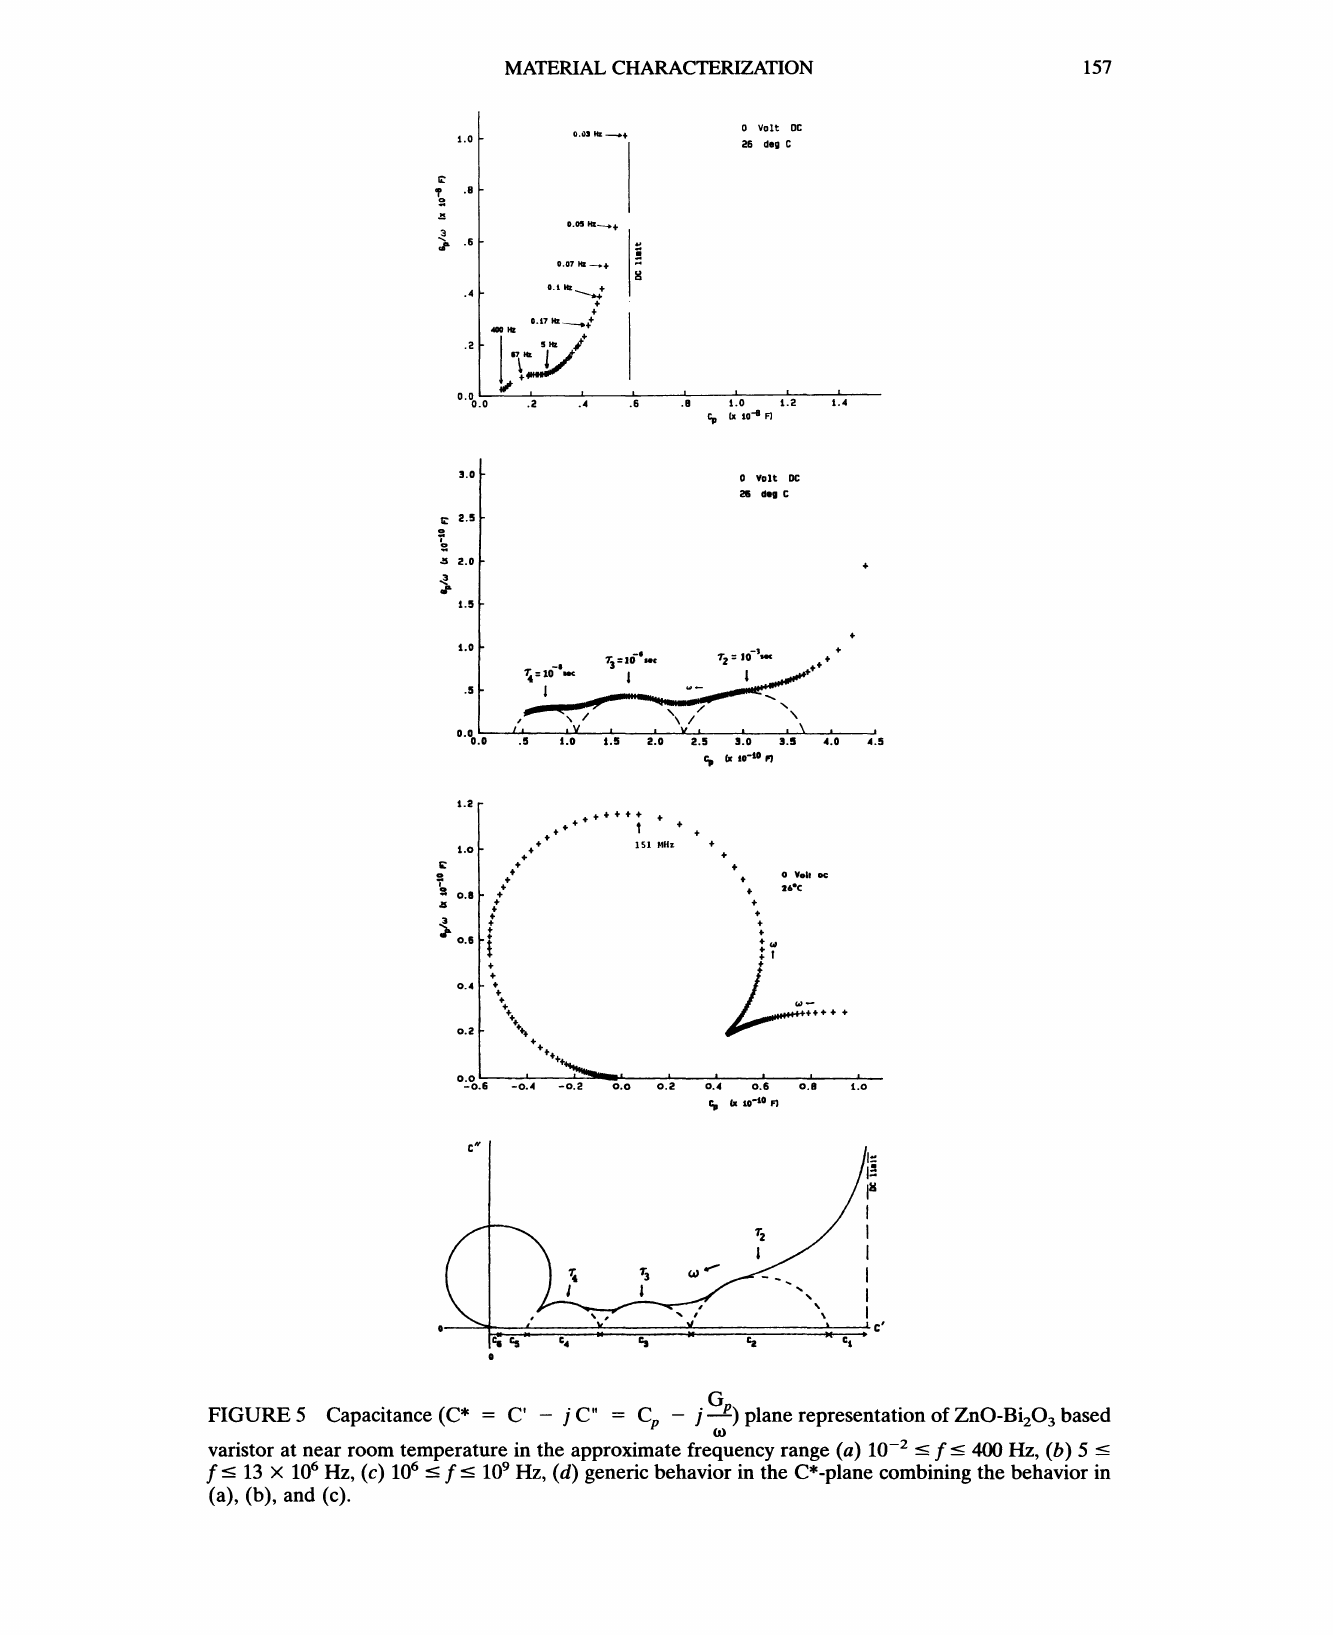
FIGURE 5 Capacitance (C* plane representation of ZnO-Bi20